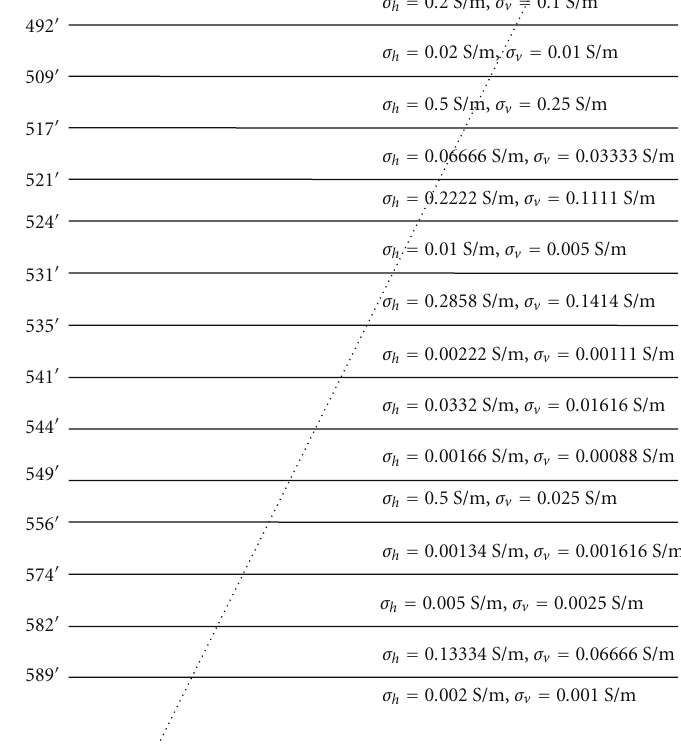
Figure 13: A fifteen-layer Oklahoma model.